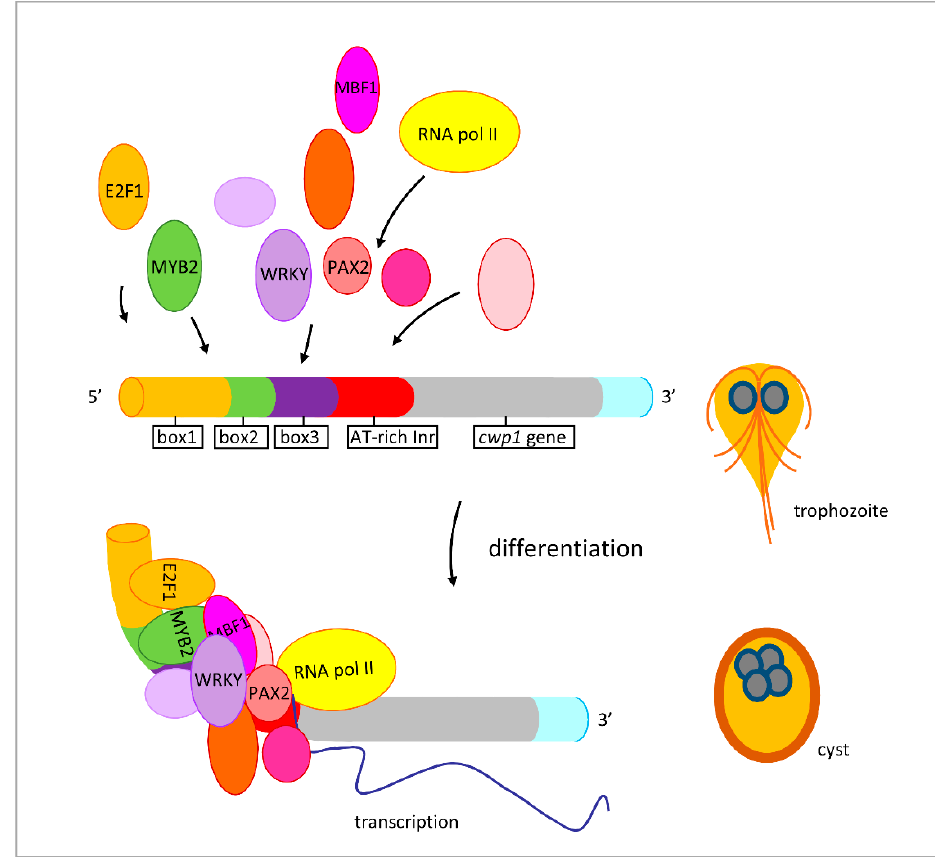
Figure 10. Increased expression of encystation-induced cwp1 gene in cyst differentiation process. One gene encoding key construction component of the cyst wall, cwp1, is up-regulated by MBF1, E2F1, Pax2, WRKY, Myb2, and other transcription factors in cyst differentiation process. These transcription factors can bind to cis-acting elements of the cwp1 promoter, such as box1-3 or AT-rich initiator (Inr), to activate cwp1 gene transcription. They can form complexes to recruit RNA polymerase II for transcription initiation. CWP1 is present in vegetative trophozoite stage at a lower level and displays higher expression levels by these transcription factors in cyst differentiation process. The increase of MBF1, E2F1, Pax2, WRKY, Myb2, and other transcription factors during encystation may further induce CWP1 expression, resulting in more cyst generation.